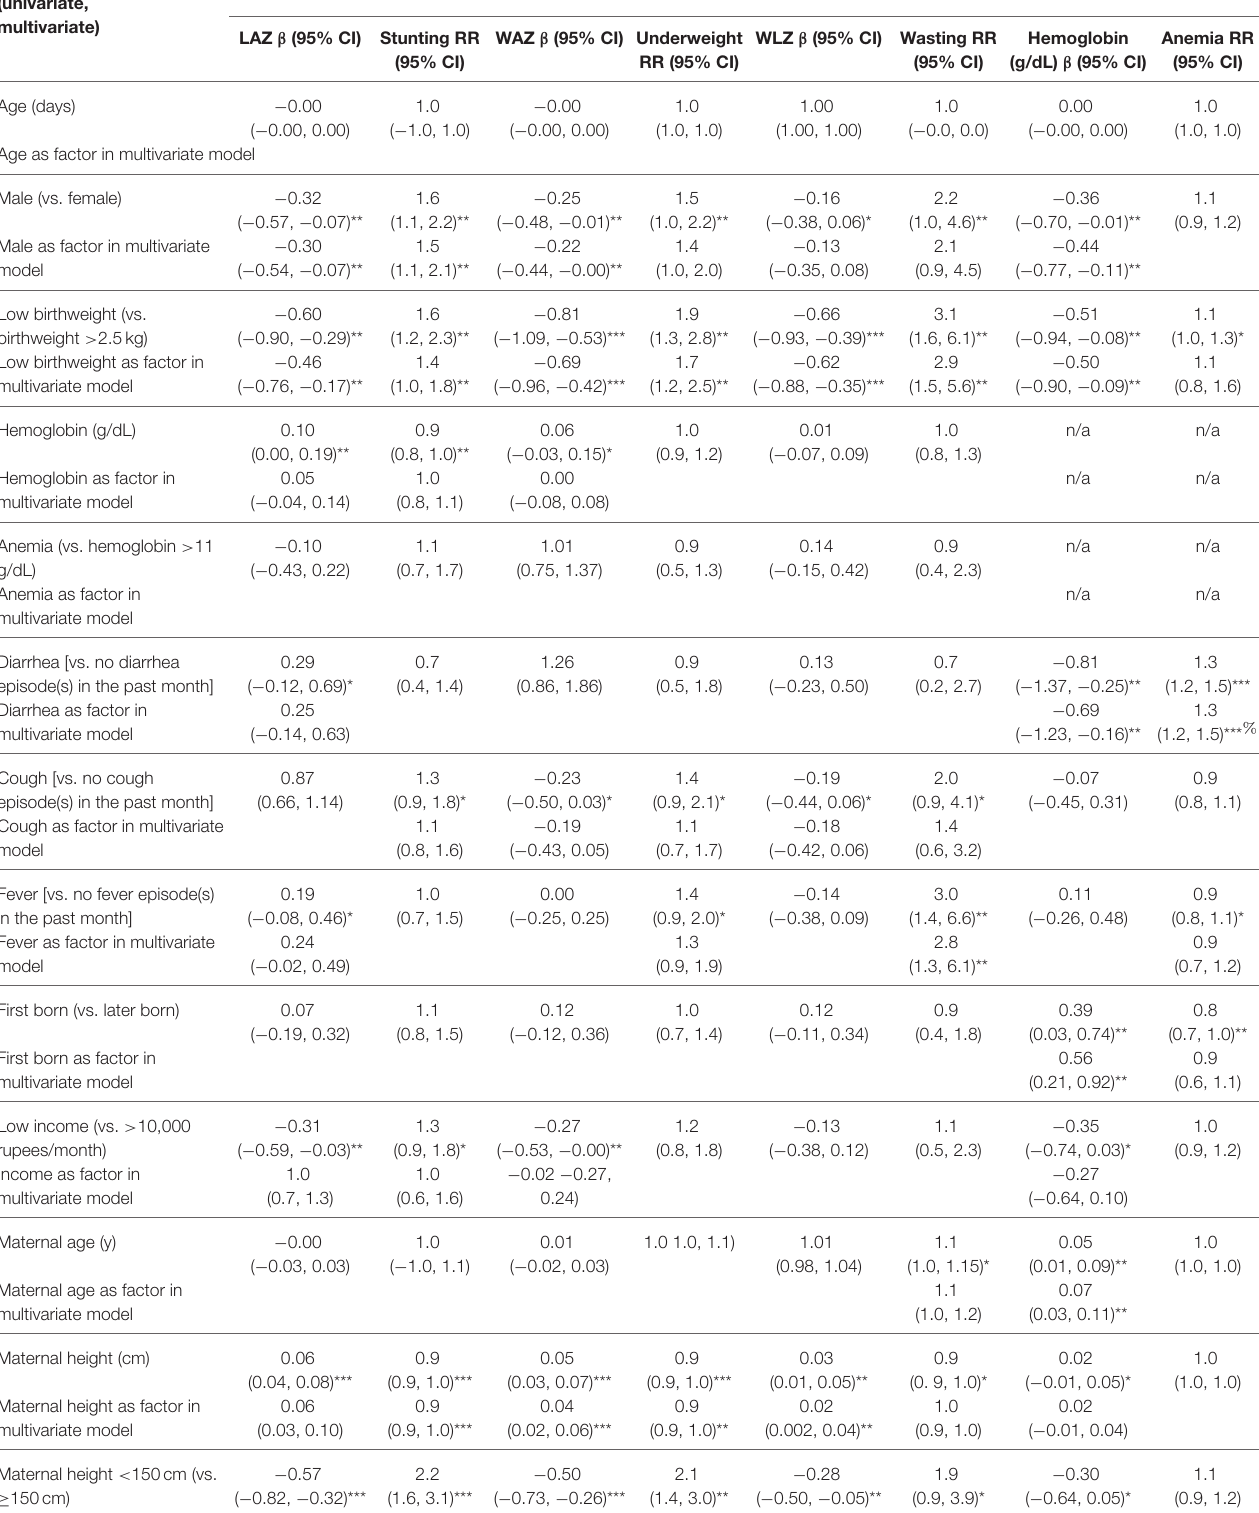
TABLE 2 | Correlates of poor growth and anemia among n = 323 children. Correlate (univariate,